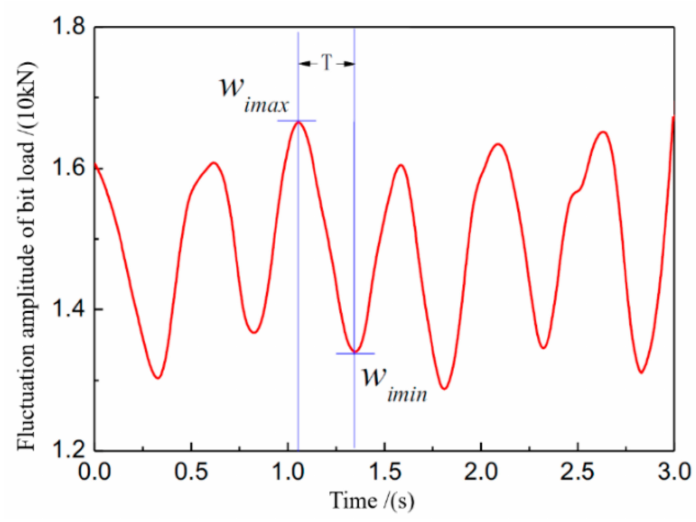
Figure 7. Diagram of fluctuation amplitude of bit load in a period time.